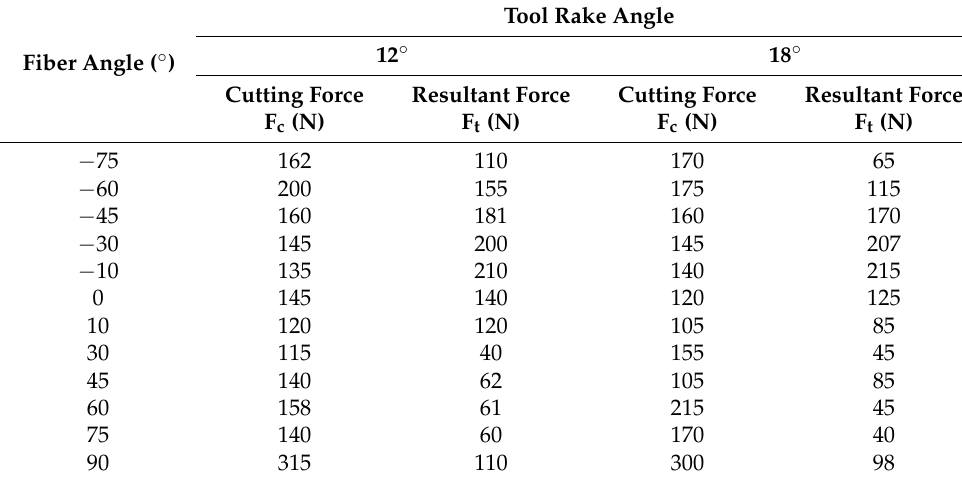
Table 3. Cutting force based on fibre angle, adapted from [34].